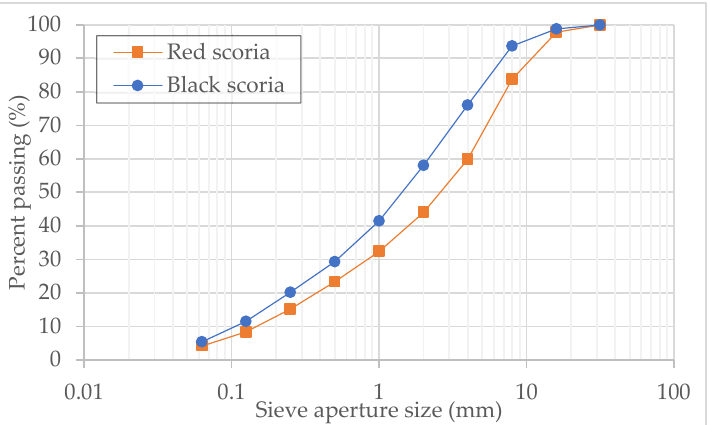
Figure 3. Particle size distribution of the red and black scoria.